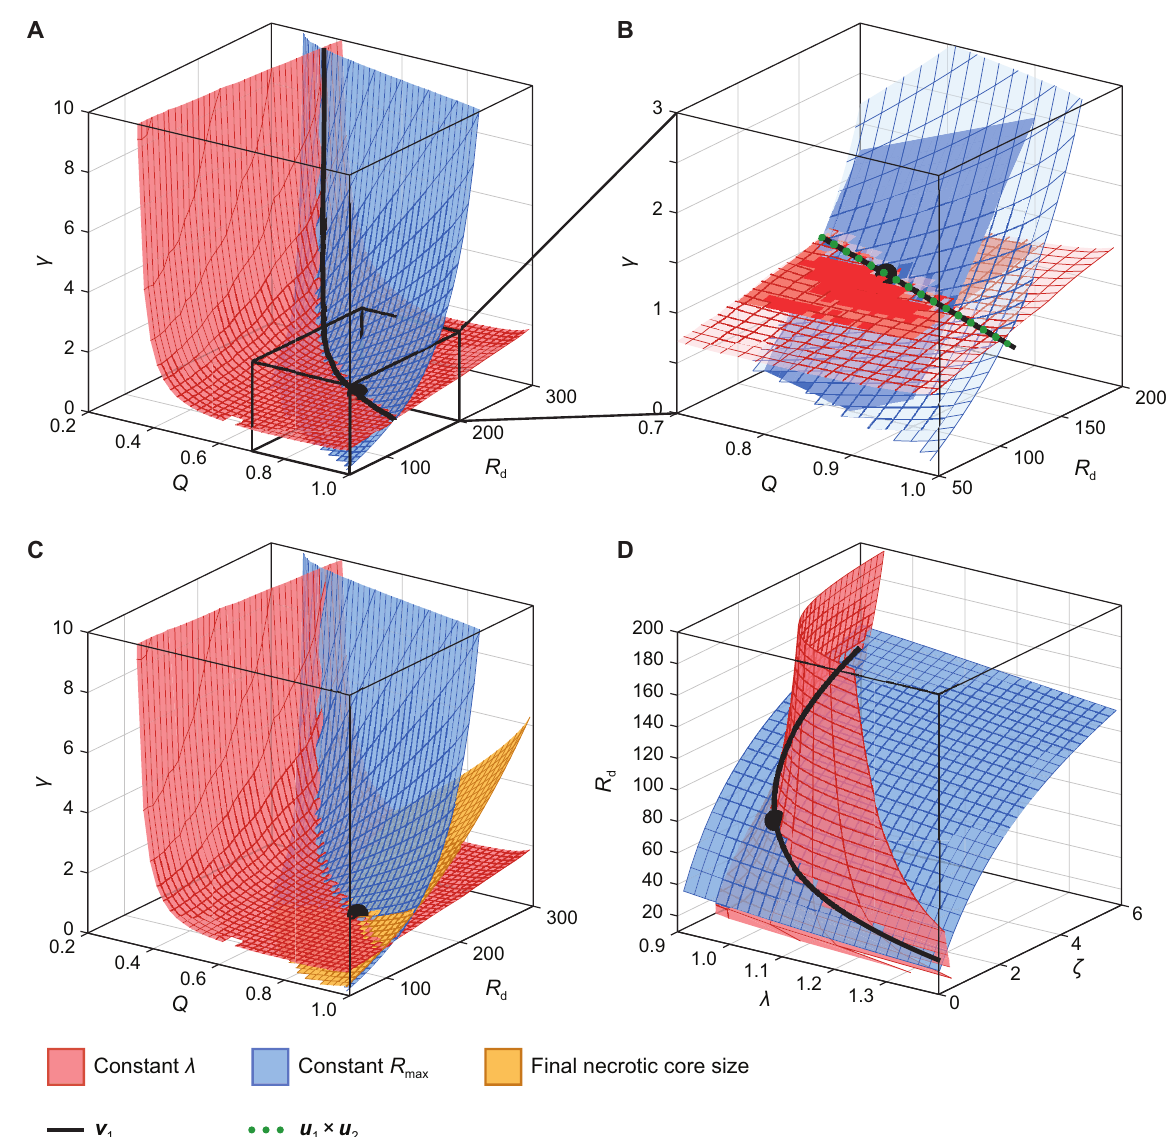
Fig 6. Visualisation of the between-model geometry between the Greenspan, logistic, and radial-death models. Surfaces correspond to manifolds in the parameter space of the (A–C) Greenspan and (D) radial-death models that give rise to (red) constant volumetric growth rate, λ , and (blue) constant maximum spheroid size, R max , when compared to the logistic model. In all cases, the parameter set used for the comparison is shown as a black disc. In (A,D), black curves correspond to the solution to Eq (32), and give the curve of near-constant likelihood. Note that this curve is visualised in front of the manifolds for clarity. In (B), we compare the manifolds (semi-transparent) to a linearisation corresponding to two planes normal to the rows of the model-map Jacobian (Eq (33)). We show the sloppy direction v 1 (black) and the cross product of the model-map Jacobian rows (green dotted). In (C) we show a third manifold corresponding to constant final necrotic core size, which is sufficient to identify the parameters in the Greenspan